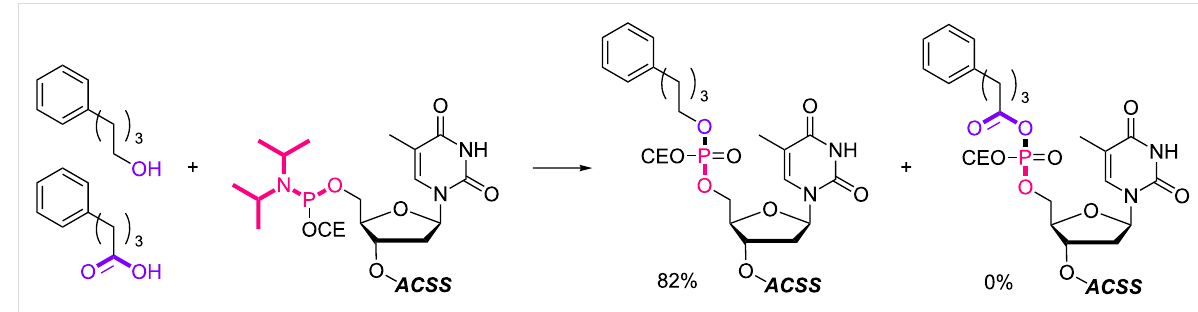
Scheme 1: Competition experiment between alcohol and carboxylic acid. Reagents and conditions: (i) 4-phenylbutyl alcohol or 4-phenylbutanoic acid (2.0 equiv), BMT (2.0 equiv), CH 2 Cl 2 /CH 3 CN (10:1, v/v), rt, 30 min; (ii) 0.67% BPO/DMP/CH 2 Cl 2 , rt, 30 min, 82% over 2